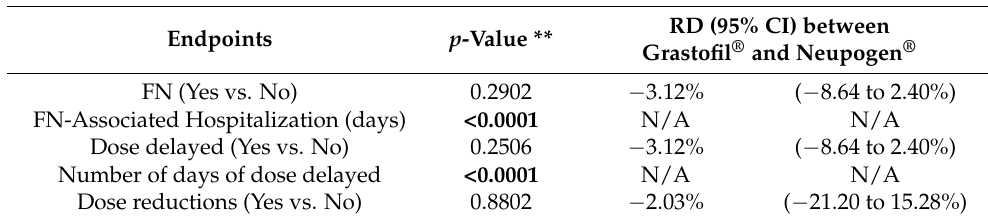
Table 8. Combined Lymphoma Risk Differences. Comparing Each of Endpoints between Grastofil ® and Neupogen ® in Total